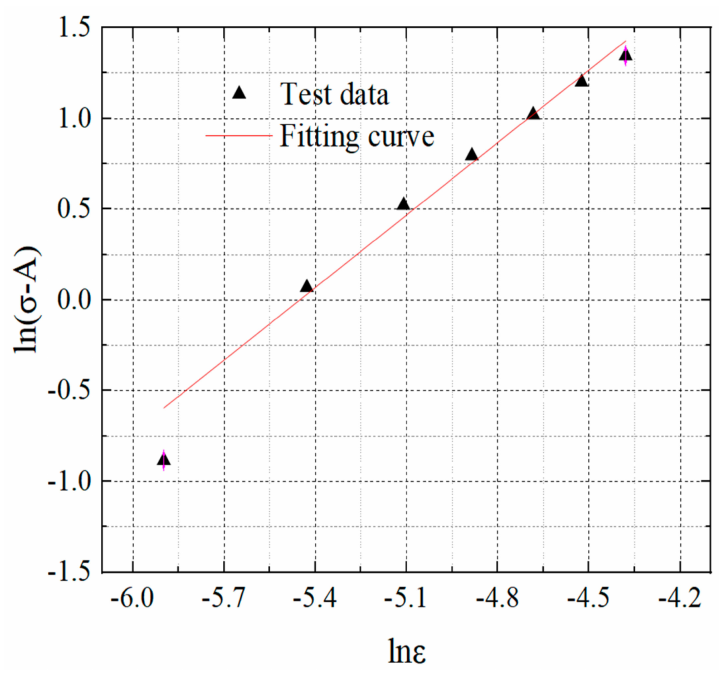
Figure 6. The relationship of ln ε and ln( σ − A